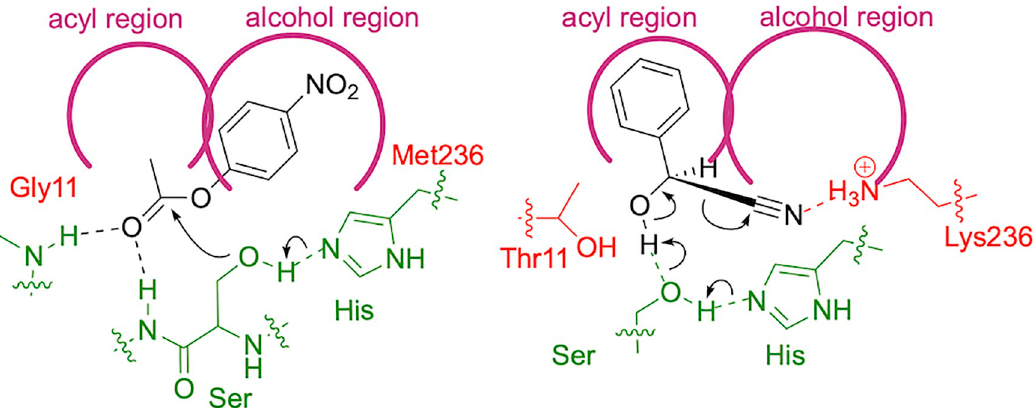
Fig 8. The aryl group placement differs for p NPAc and mandelonitrile. During ester hydrolysis (left scheme), the p -nitrophenyl moiety of the ester orients in the alcohol region of the substrate binding site. During cyanohydrin cleavage, the phenyl group of mandelonitrile orients in the acyl region of the substrate-binding site. The catalytic triad and oxyanion hole residues are in green, the residues associate with ester catalysis (Gly11, Met236) or HNL catalysis (Thr11, Lys236) are shown in red, the substrates are in black and the substrate binding site is shown schematically in